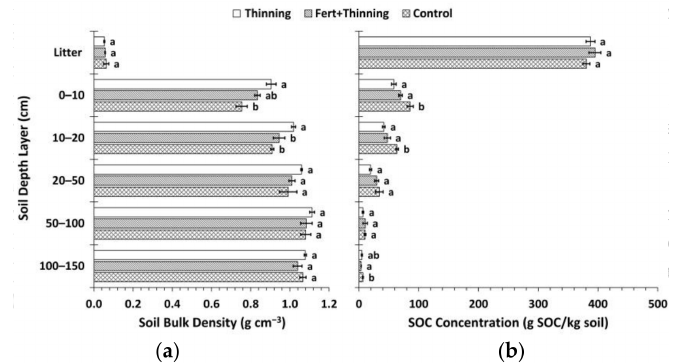
Figure 2. ( a ) Mean soil bulk density by treatment; ( b ) mean soil organic carbon (SOC) concentration by treatment. Sample size for all treatments and soil depth layers is three. Error bars represent ± one standard error. Means within each soil depth layer accompanied by the same letter (i.e., “a” or “b”) are not significantly different (Tukey’s honest significant difference (HSD), α = 0.1). Fert, fertilized.